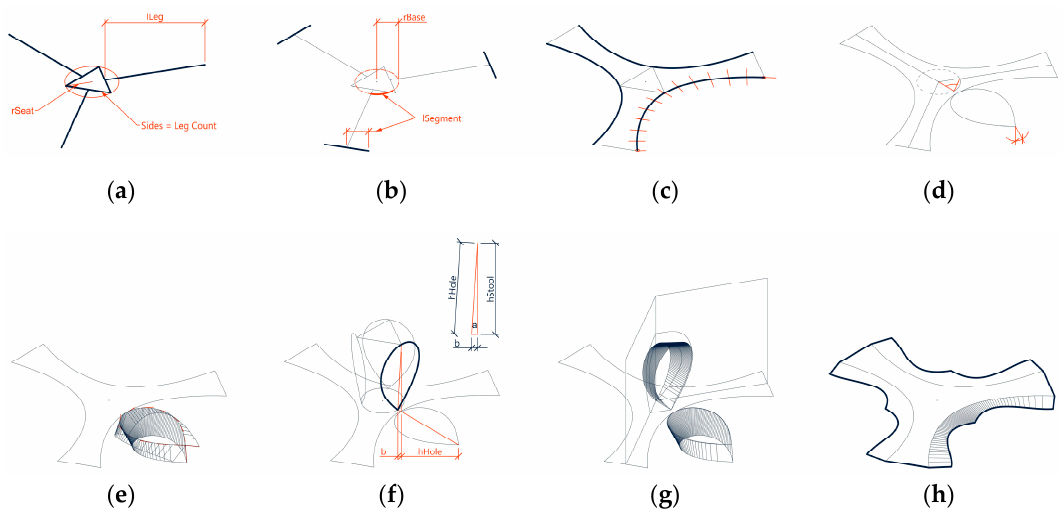
Figure 6. Geometric form-finding for a stool with three legs. Definition of the base polygon ( a ), base radius determination ( b ), construction of base arc-curve ( c ), construction of fully folded spatial curve ( d ), construction of ruled surface ( e ), inclination of the spatial curve towards base circle center ( f ), orientation of ruled surface along the inclined spatial curve ( g ), mapping of ruling lengths ( h ).